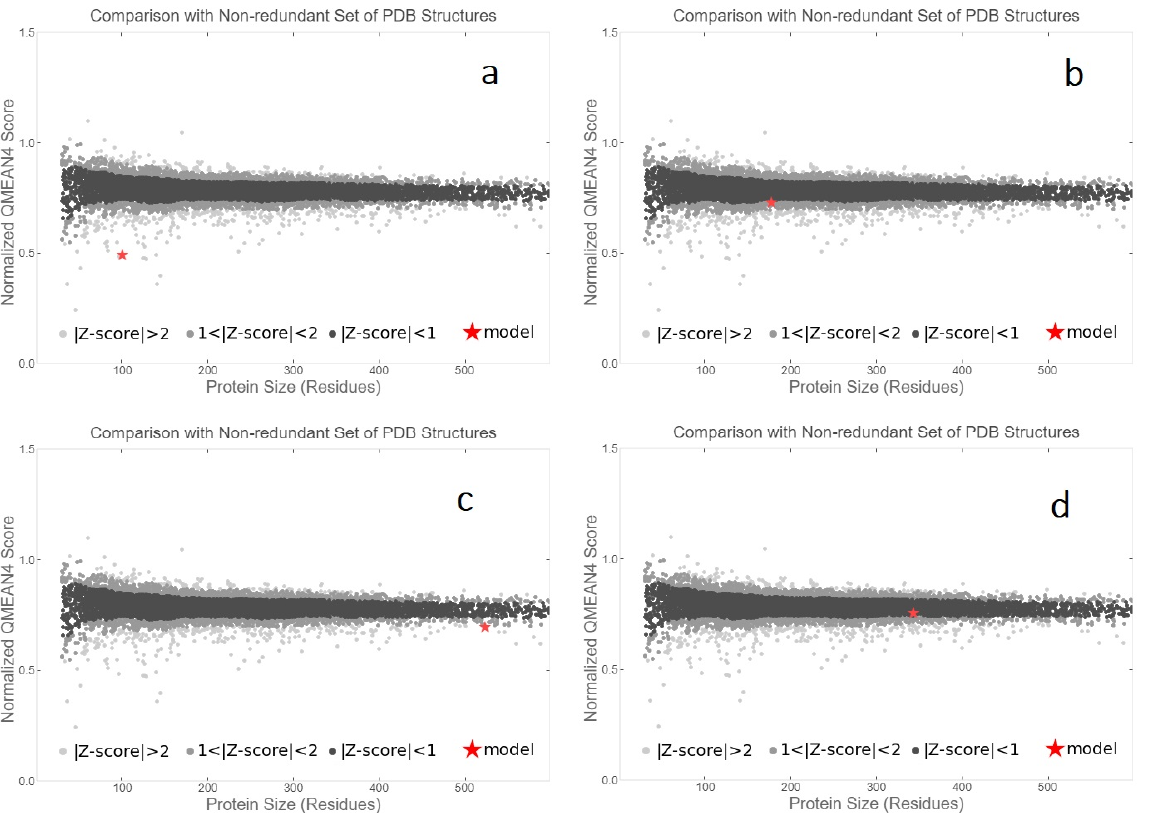
Figure A2. Comparison of the modeled structures to the set of non-redundant crystallographic proteins in the Protein Data Bank: ( a ) membrane protease; ( b ) spike receptor-binding domain; ( c ) nonstructural protein 14; ( d ) transmembrane protease, serine 2. The plots demonstrate that the model quality scores of the individual models are comparable with scores attained for experimental structures of similar size. The x-axis represents the number of residues in the protein; the y-axis represents the QMEAN score. Each dot indicates a single experimental protein structure. Normalized QMEAN scores within 1 standard deviation of mean, Z score (0 to 1), are shown in black dots, those with a Z score between 1 and 2 in grey, and those with a Z score above 2 in light grey, while the actual model is represented as a red star.